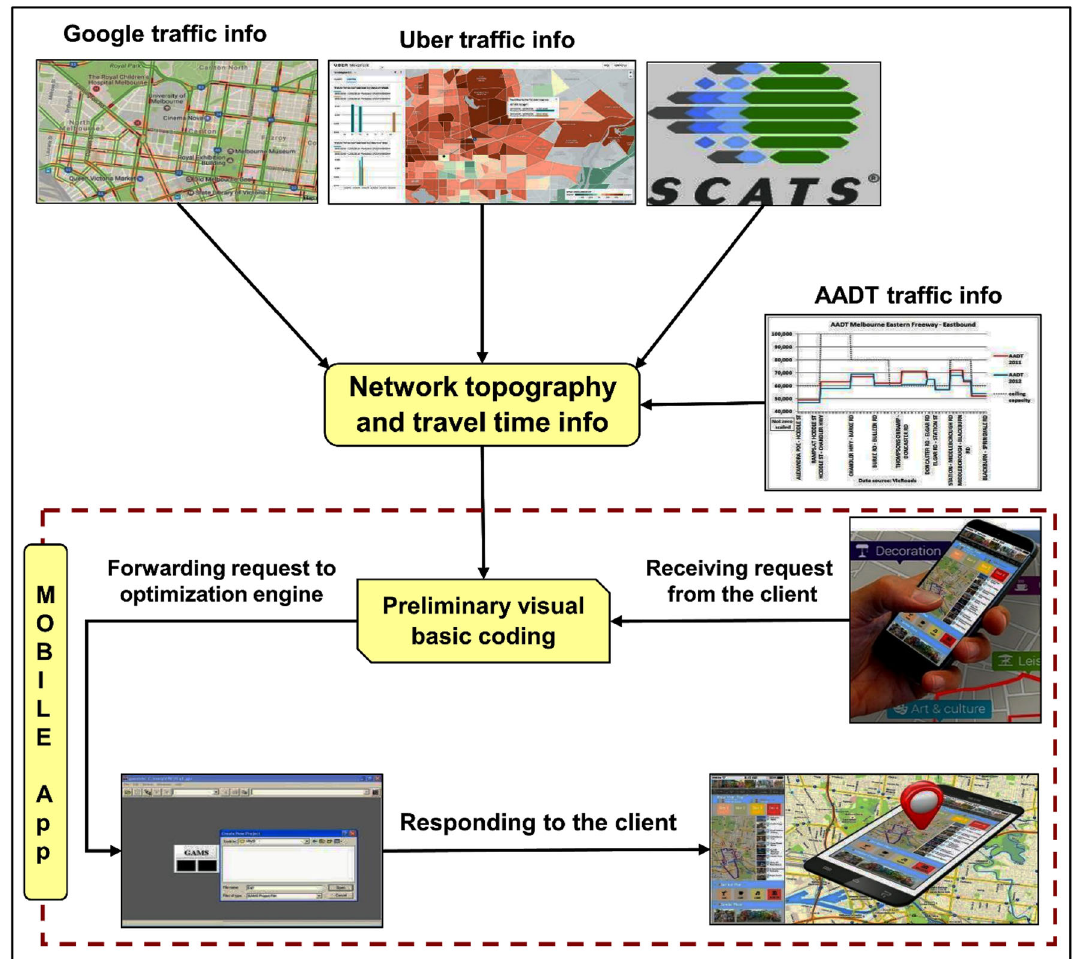
Fig. 3 A schematic view of the architecture of the decision support system